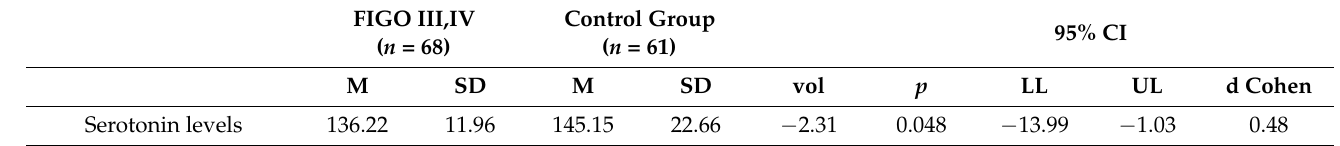
Table 6. Serotonin preoperative levels in the study group (with ovarian cancer—III–IV stage according to FIGO) and the control group (with benign neoplastic lesions and simple ovarian cysts). FIGO III,IV